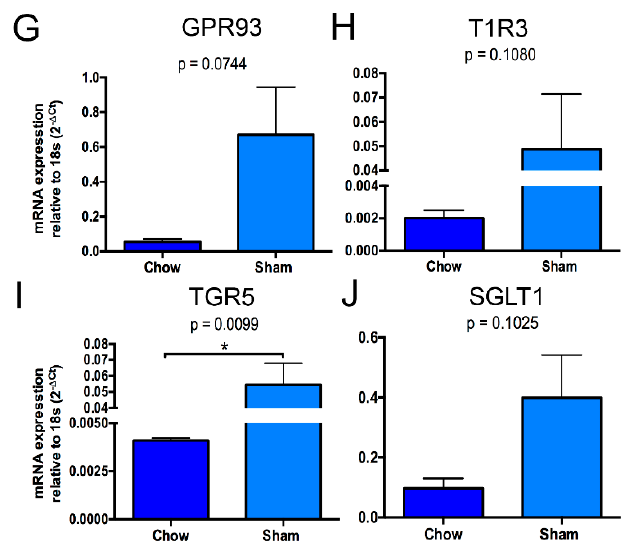
Figure 1. mRNA expression levels in chow (lean) vs. sham (obese) of short-chain fatty acid receptors GPR41 and GPR43 ( A , B ), medium-chain fatty acid receptors GPR40, GPR84 and GPR120 ( C – E ), lipid amide sensor GPR119 ( F ), amino acid-sensing receptors GPR93 and T1R3 ( G , H ), bile acid sensor TGR5 ( I ), and sodium-glucose co-transporter SGLT1 ( J ). The expression is described relative to 18s and represents N = 5–7. Error bars show SEM, and significance is p < 0.05 as denoted by *.